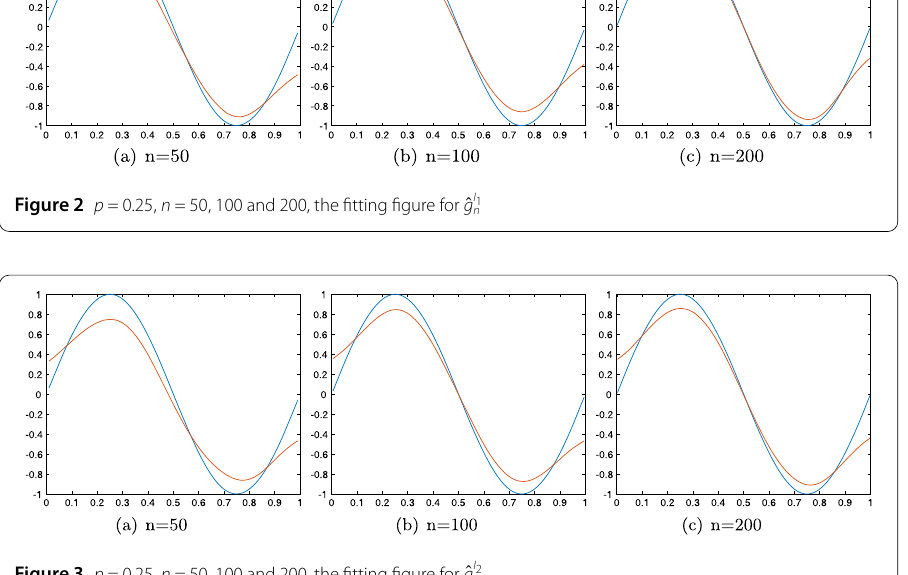
(vi) The simulation results are consistent with the theoretical